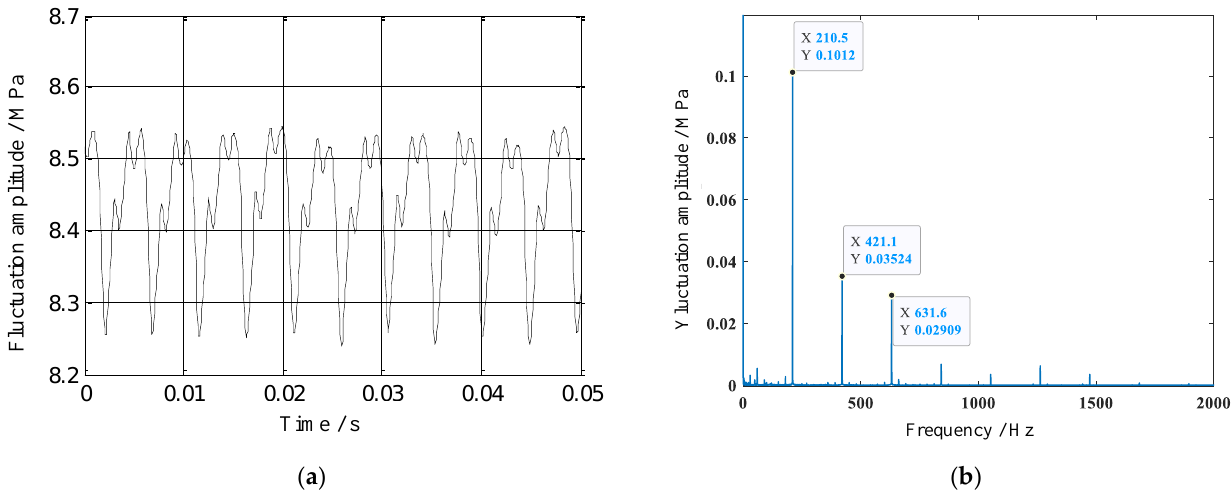
Figure 13. Load pressure ( p 2 = 8.38 MPa) waveform. ( a ) Time domain diagram; ( b ) frequency domain map.